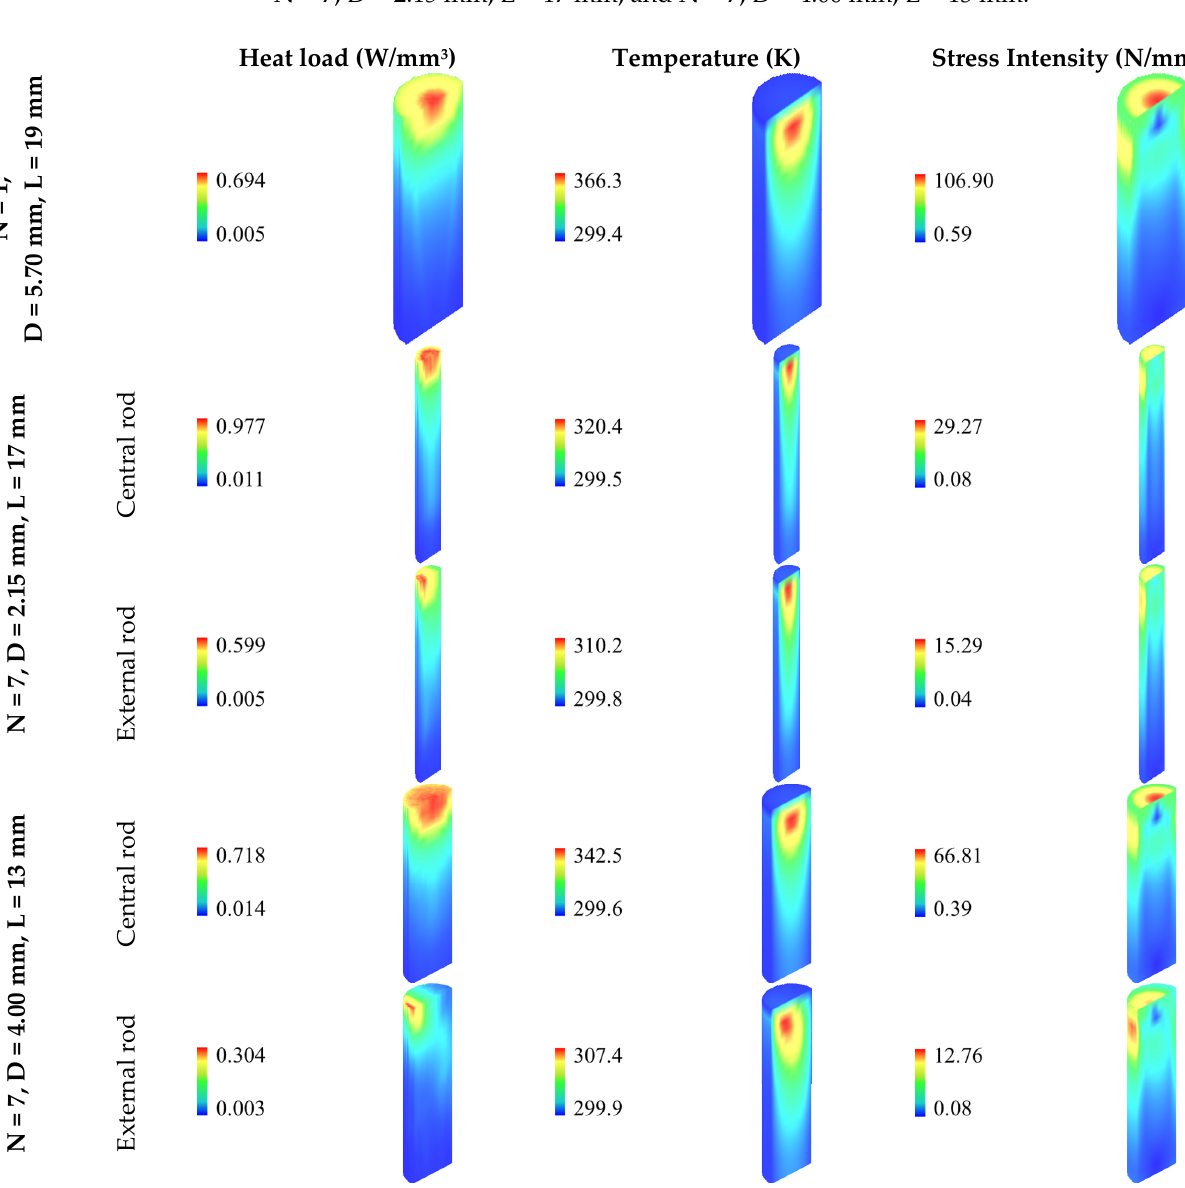
Figure 11. Heat load, temperature and stress intensity for the central and one external Nd:YAG rods from three of the schemes tested: N = 1, D = 5.70 mm, L = 19 mm; N = 7, D = 2.15 mm, L = 17 mm; and N = 7, D = 4.00 mm, L = 13 mm.